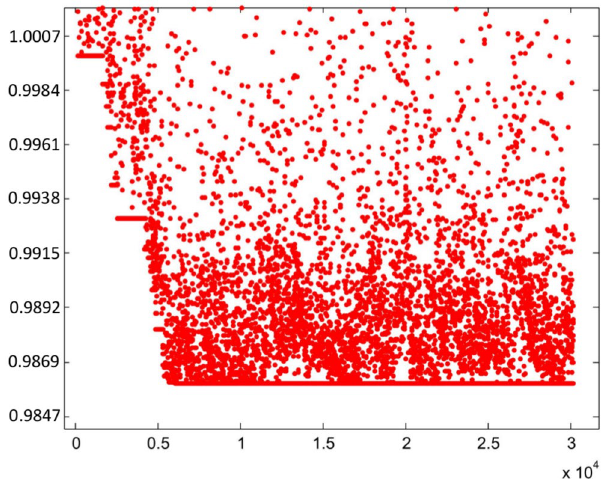
Figure 4. This figure shows the behavior of the objective function f obj defined in Eq. (21) as the number of iterations increases. The vertical axis represents the relative value of the objective function with respect to its initial value f initial obj , and the horizontal axis represents the cumulative CPU time (in seconds) as iterations proceed.